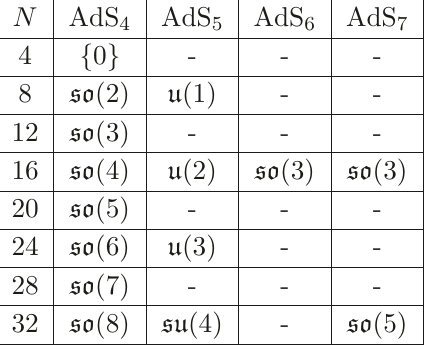
The commutators of K r with the odd generators have been found using a similar argument to that of the AdS 6 backgrounds. The Lie algebra of the K r generators is so (3). The KSA is isomorphic to osp (6 , 2 |